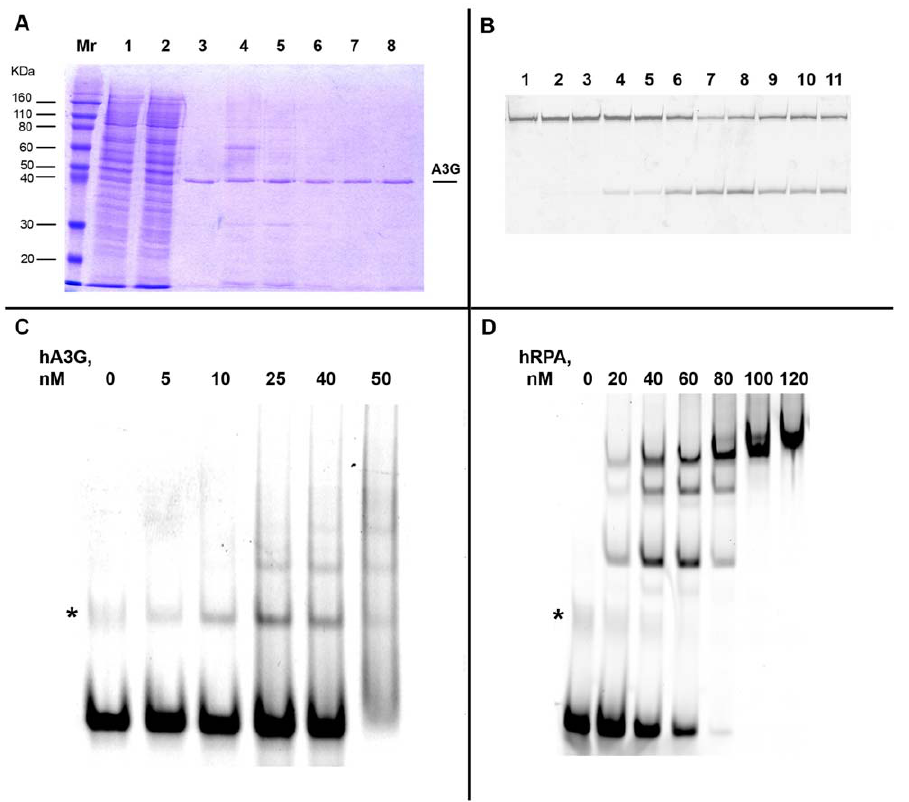
Figure 5. Purification and characterization of proteins used in the study. a. Coomassie-stained 12% SDS-PAGE gel of aliquotes from different steps of A3G purification from HEK293T cells. Mr – molecular weight marker, 1 – clarified lysate, 2 – flow through, 3–8 – different protein- containing fractions, eluted from the resin. b. Deaminase activity of purified A3G, detected in the oligonucleotide assay with uracil-DNA-glycosylase. In this assay, after deaminase converts cytosine to uracil, uracil-DNA-glycosilase removes uracil from the DNA, leading to formation of the AP site, which is further converted into strand break under conditions of high pH and temperature. 1 – UDG alone, 2 - A3G-expressing HEK293T lysate, 3 – clarified lysate, 4 – clarified lysate treated with RNAse, 5 – flow through, 6–11 – different fractions of purified protein. c and d. DNA-binding activity of purified A3G (c) and human RPA (d), detected by electromobility shift assay (EMSA). A3G from fraction 5 (see panel a) was used in this assay. The same oligonucleotide was used for both proteins (c). The band that corresponds to the free oligonucleotide folded to the secondary structure is indicated by the asterisk. Note that in (c) this non-specific band migrates similarly to the fastest A3G-shifted band.